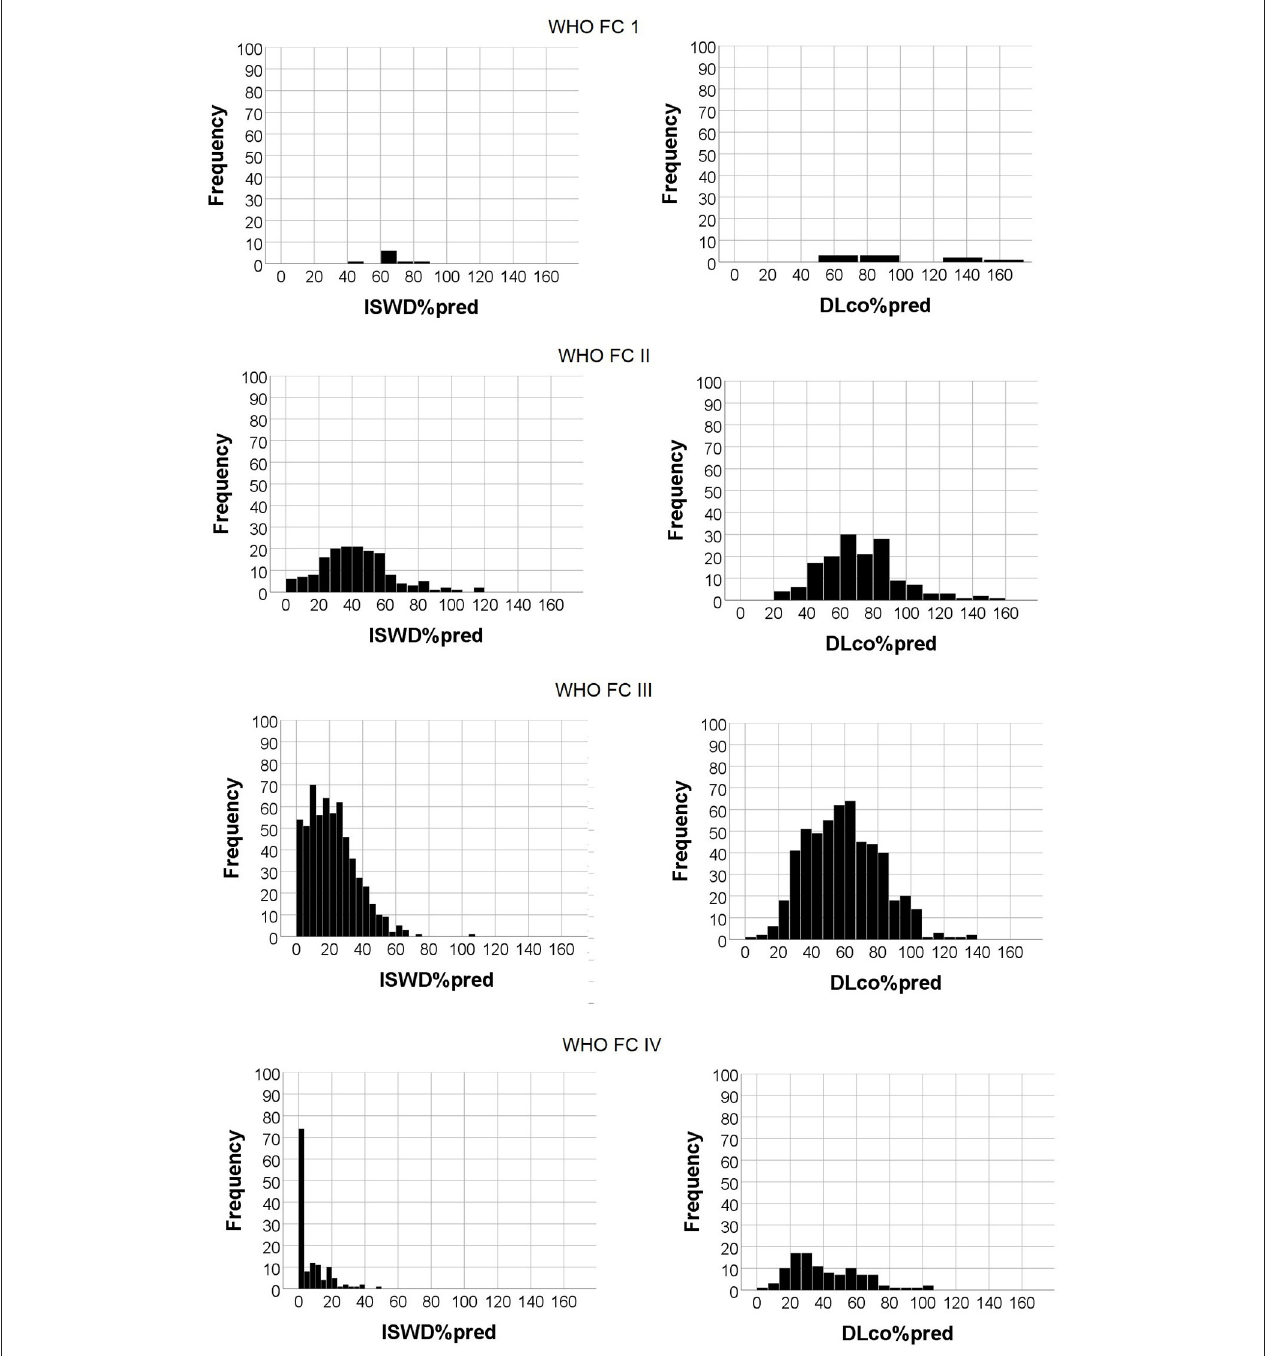
FIGURE 2 | Histogram of Incremental shuttle walk distance percent predicted (ISWD%pred) and Diffusing capacity across the lung for carbon monoxide percent predicted (DLco%pred) frequencies by World Health Organization functional